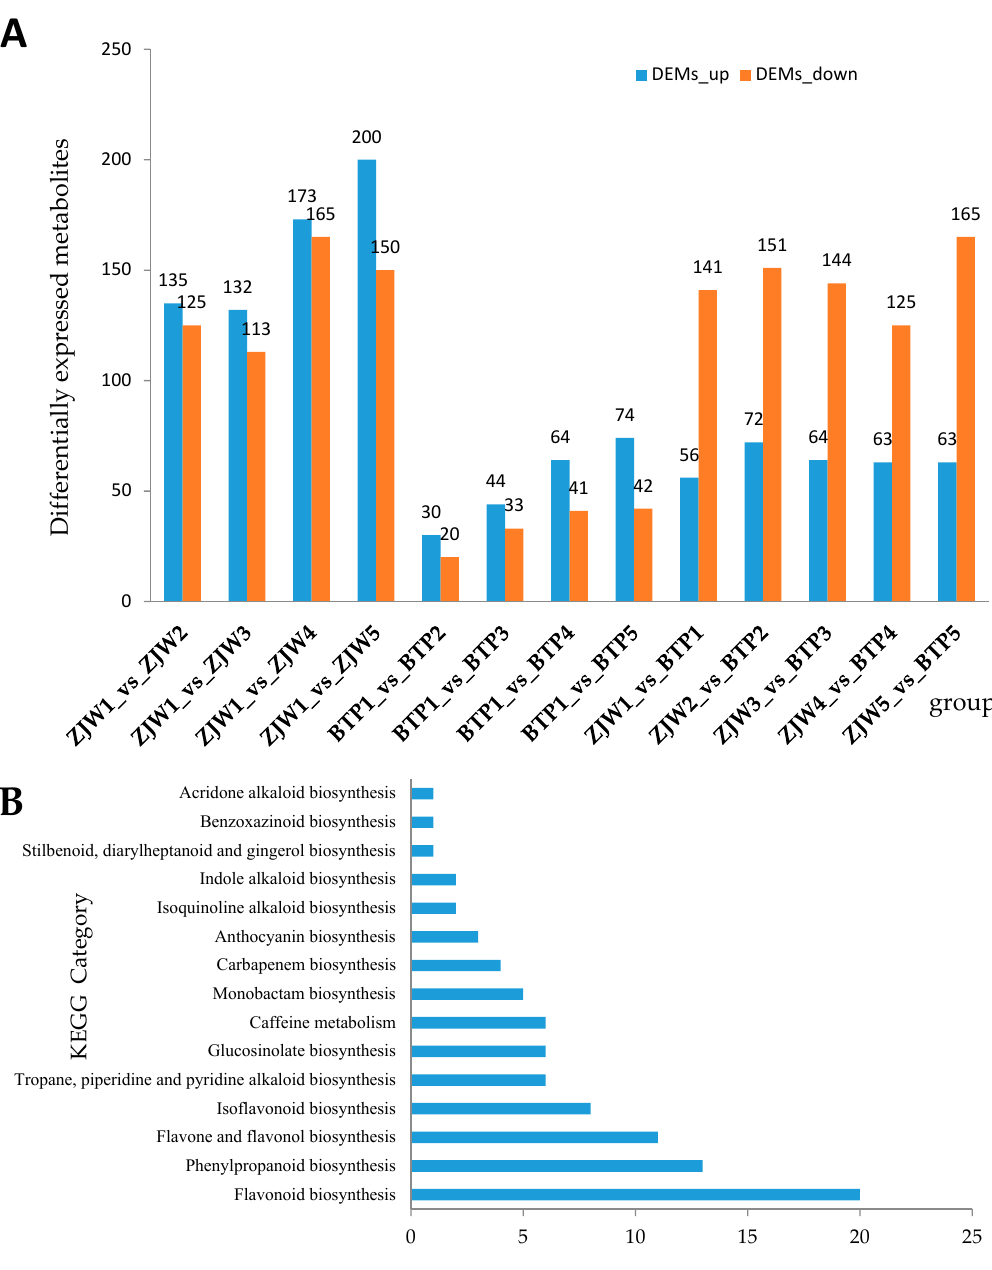
Figure 3. The number of differentially expressed metabolites (DEMs) and the number of KEGG pathway annotations for secondary metabolism. ( A ) DEMs in ZJW and BTP tea flower. ( B ) The number of KEGG pathway annotations involved in secondary metabolism of ZJW and BTP tea flower from S1 to S5.